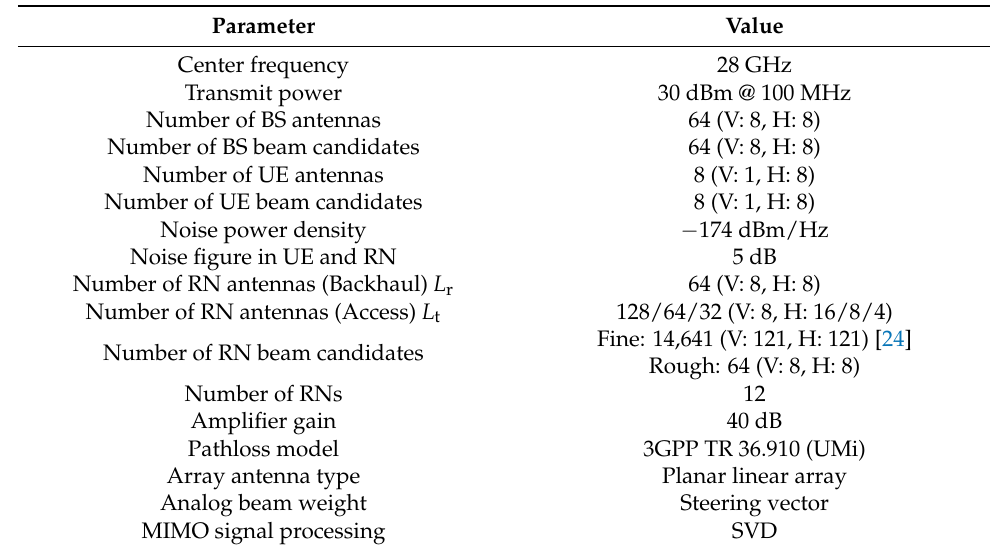
Figure 5. Simulation model. Table 1. Simulation parameters.